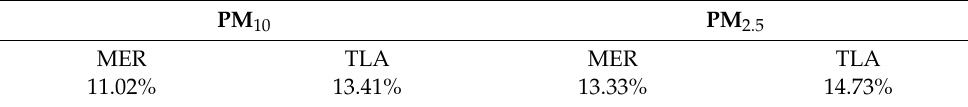
Table 2. Percentages of outliers.